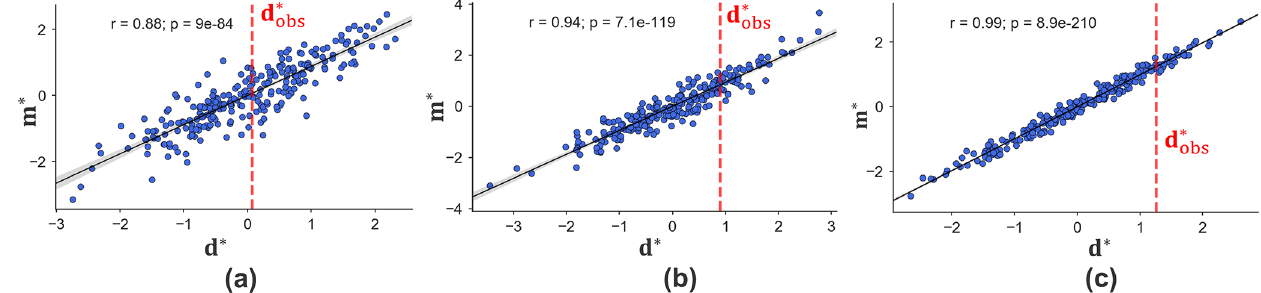
Figure 15. First canonical covariates of data and model variables from (a) porosity, (b) log-perm, and (c)